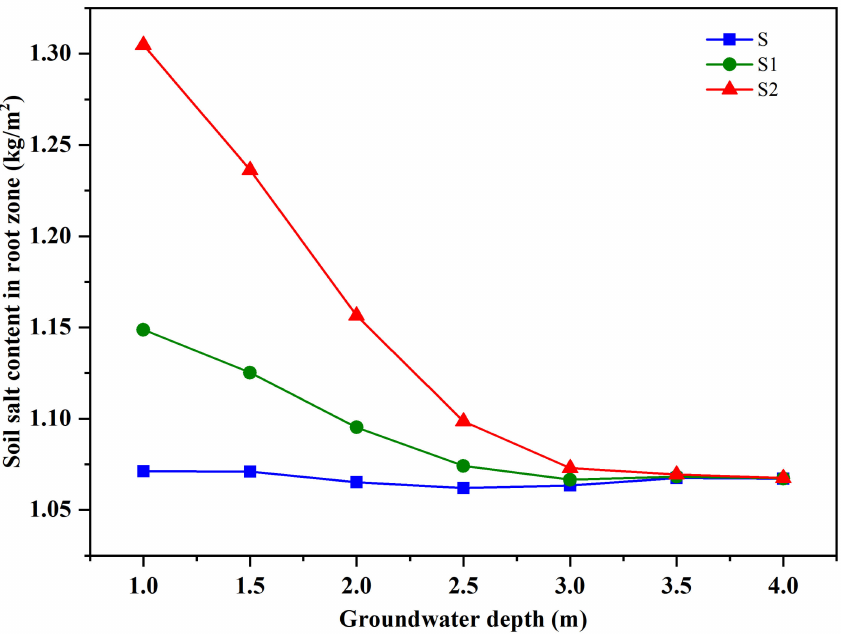
Figure 4. Soil salt content in root zone during the growing period with groundwater depth ranging from 1 m to 4 m and groundwater salinity ranging from 1 to 4 g / L. Note: S, S1 and S2 refer to the scenarios with groundwater salinity of 1, 2 and 4 g / L, respectively.